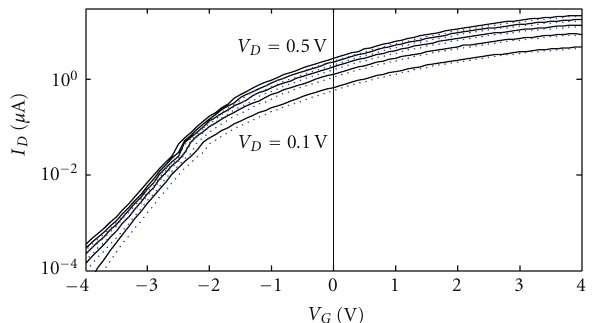
Figure 4: Measured I DS - V GS characteristics (semilog) taken at dark (solid line) and under room light illumination (dashed line). The dashed line is slightly shifted to more positive V GS values especially in the depletion and the di ff usion modes ( V GS < 1 . 77